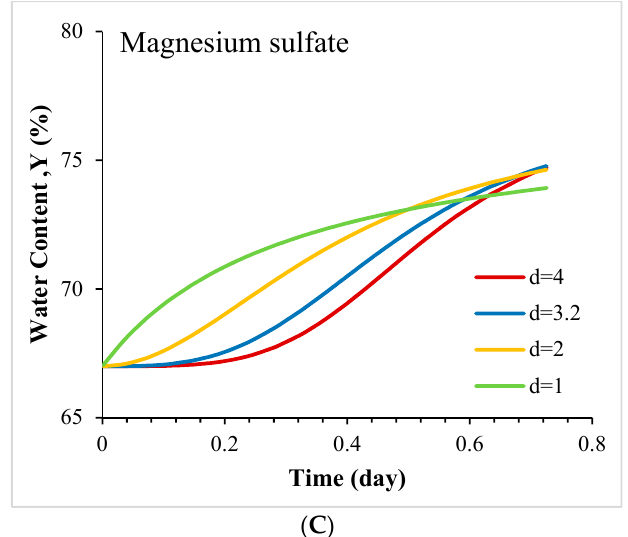
Figure 7. Water vapor absorption curves of the three ( A ) copper chloride, ( B ) copper sulfate, and ( C ) magnesium sulfate under different uniformities of their stratified structures ( d ).